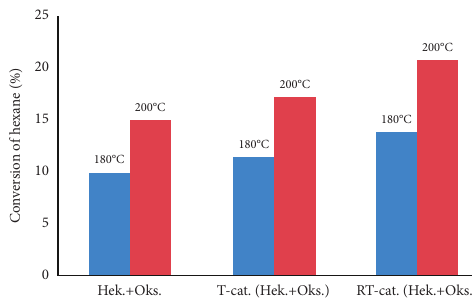
Hek.+Oks. Figure 5: Comparison of the conversion of hexane in air in homo and hetero phases at different temperatures.